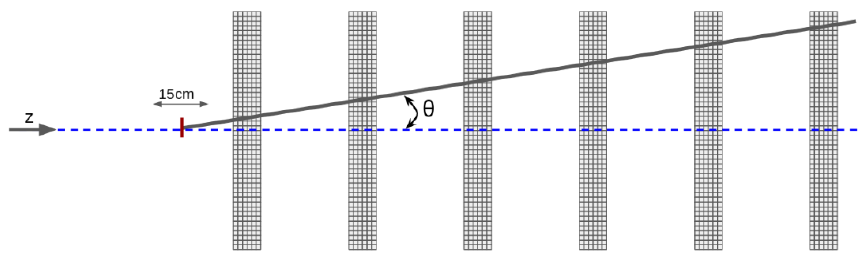
Figure 1. A sketch of the toy problem analyzed by GlueX modeled on the Forward Drift